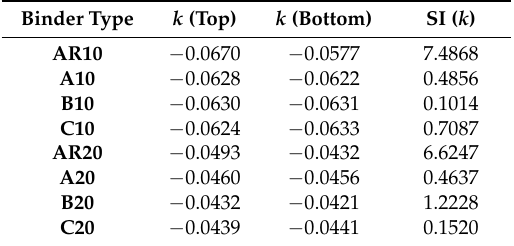
Table 9. Temperature sensitivity evaluation results for different asphalt